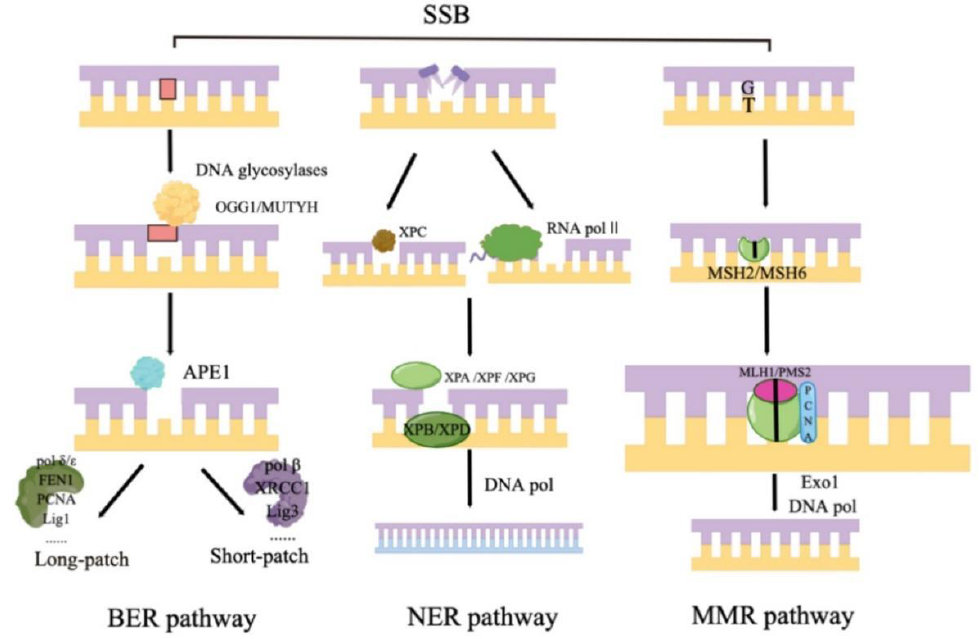
Figure 2. Different pathways of DNA single-strand breaks repair. BER pathway: base damage is recognized by DNA glycosylases that are monofunctional, bifunctional, or Nei-like. APE1 immedi- ately incises the DNA backbone 5′ to the abasic site to generate a gap, which is then filled by a DNA polymerase. The repair synthesis step then branches into two pathways, single-nucleotide-patch BER (SP-BER) and long-patch BER (LP-BER). They all consist of different enzymes. NER pathway: This repair pathway is divided into two branches due to different ways of sensing damage, in the GG-NER pathway, the damage sensor XPC probes the DNA for helix-distorting lesions, and RNA pol II indirectly detects the existence of damage in the other way. Next step, their pathway merges, and XPB and XPD verify the DNA damage. Finally, as with other pathways, a series of proteins perform damage cleavage and nick ligation. MMR pathway: Mispair is recognized by MutS homologs and then recruits MutL homologs and EXO1 exonuclease. Lastly, the daughter strand is excised, and the replicative DNA polymerases fill the gap. (By